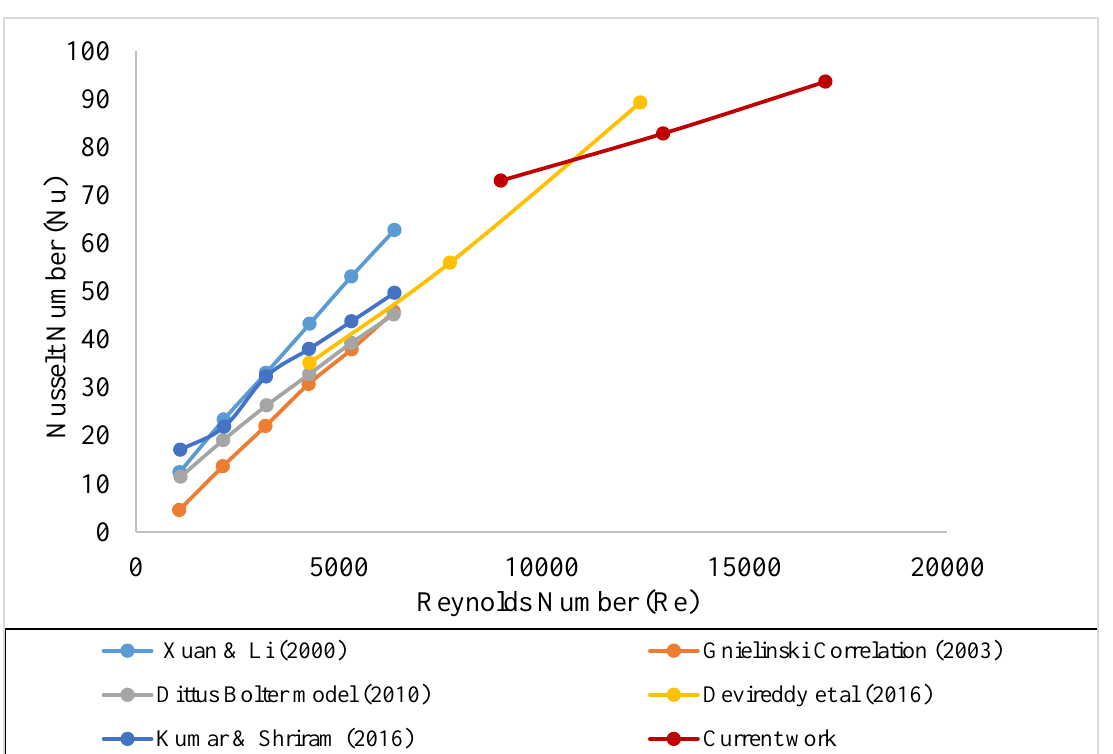
Figure 21. Interaction of the thermal conductivity with Nanofluid concentration.